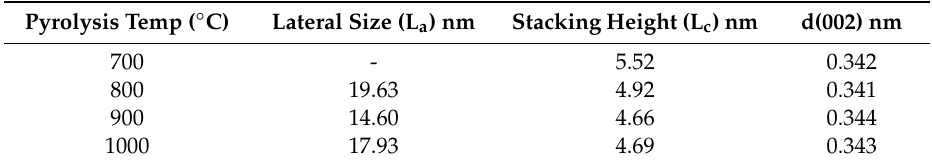
Table 2. Structural parameters calculated from XRD patterns of the C2-Fe sample prepared using FeCl 3